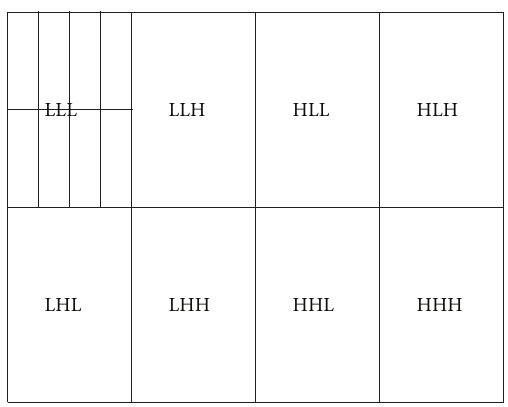
Figure 1: Frequency decomposition of SAWT( 𝑀 Λ ,2,1) along 0 ∘ , where two decomposition levels are used. 𝐻 and 𝐿 stand for high pass and low pass,